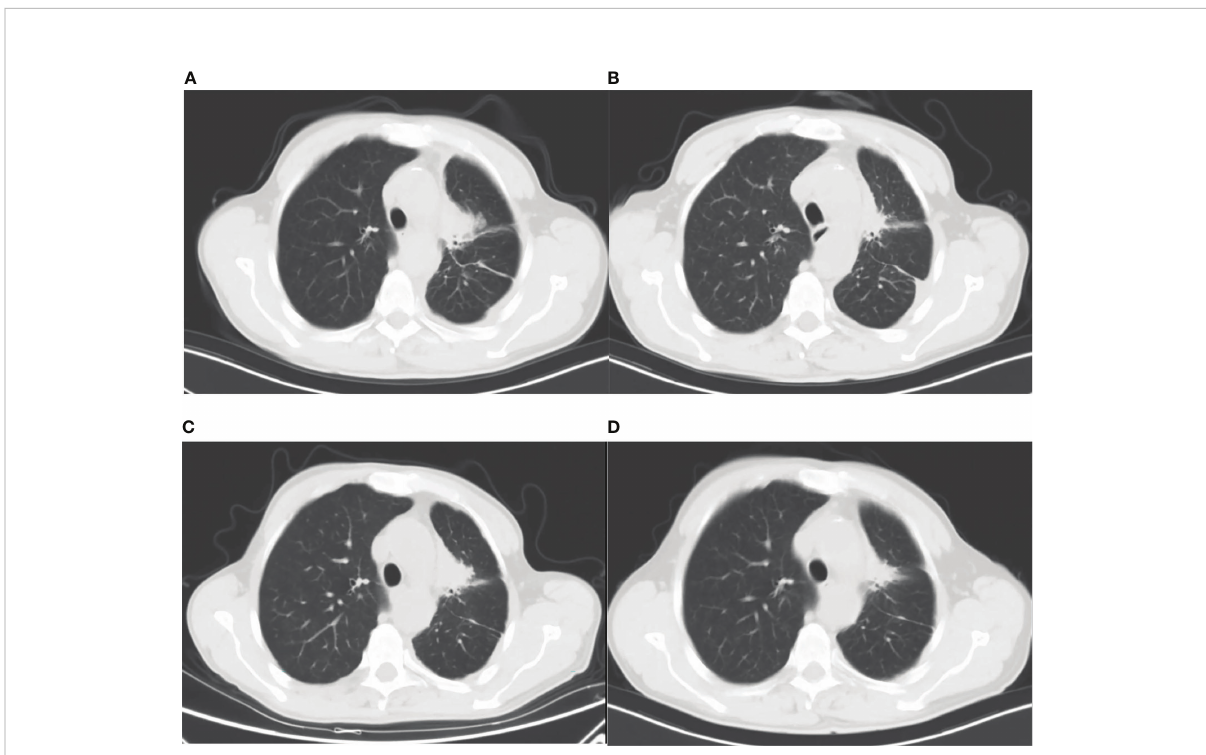
FIGURE 1 Lung CT images: (A) before dacomitinib administration; (B) 37 days after dacomitinib administration; (C) 50 days after dacomitinib termination; and (D) 95 days after afatinib